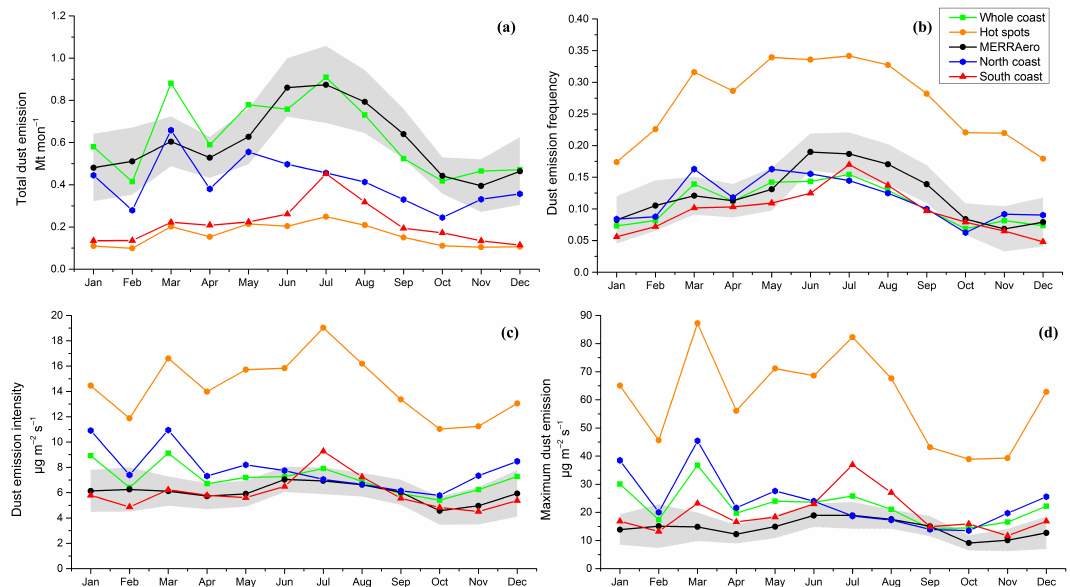
Figure 7. Average seasonal cycles of monthly (a) total dust emission (Mtmonth − 1 ), (b) dust event frequency, (c) average emission inten- sity (µgm − 2 s − 1 ), and (d) maximum emission rate (µgm − 2 s − 1 ) in 1kmALL experiment with SEVIRI source function (2009–2011) and MERRAero (2003–2015). MERRAero standard deviation intervals are shown by